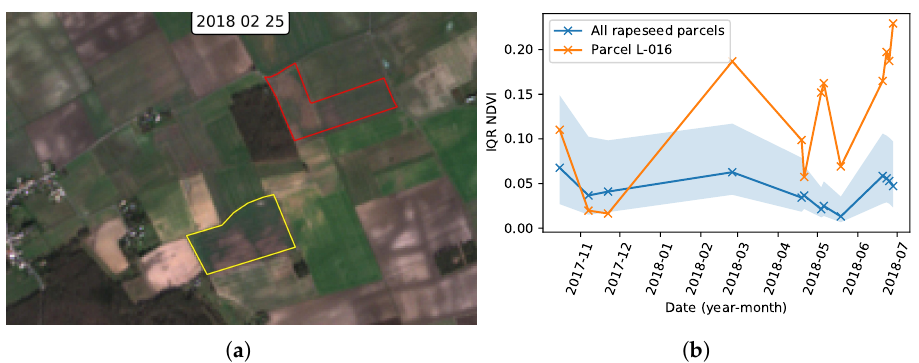
Figure 6. Example of heterogeneity affecting rapeseed parcels. ( a ): true color S2 image in February (the yellow boundary corresponds to the analyzed parcel). ( b ): Interquartile range (IQR) time series of the parcel NDVI. The blue line is the median value of the whole dataset. The blue area is filled between the 10th and 90th percentiles. The orange line is the IQR NDVI time series for the analyzed